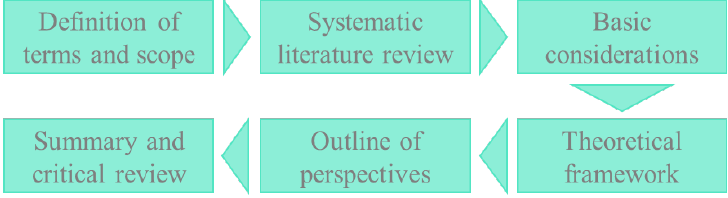
Figure 3. Research process of this paper.